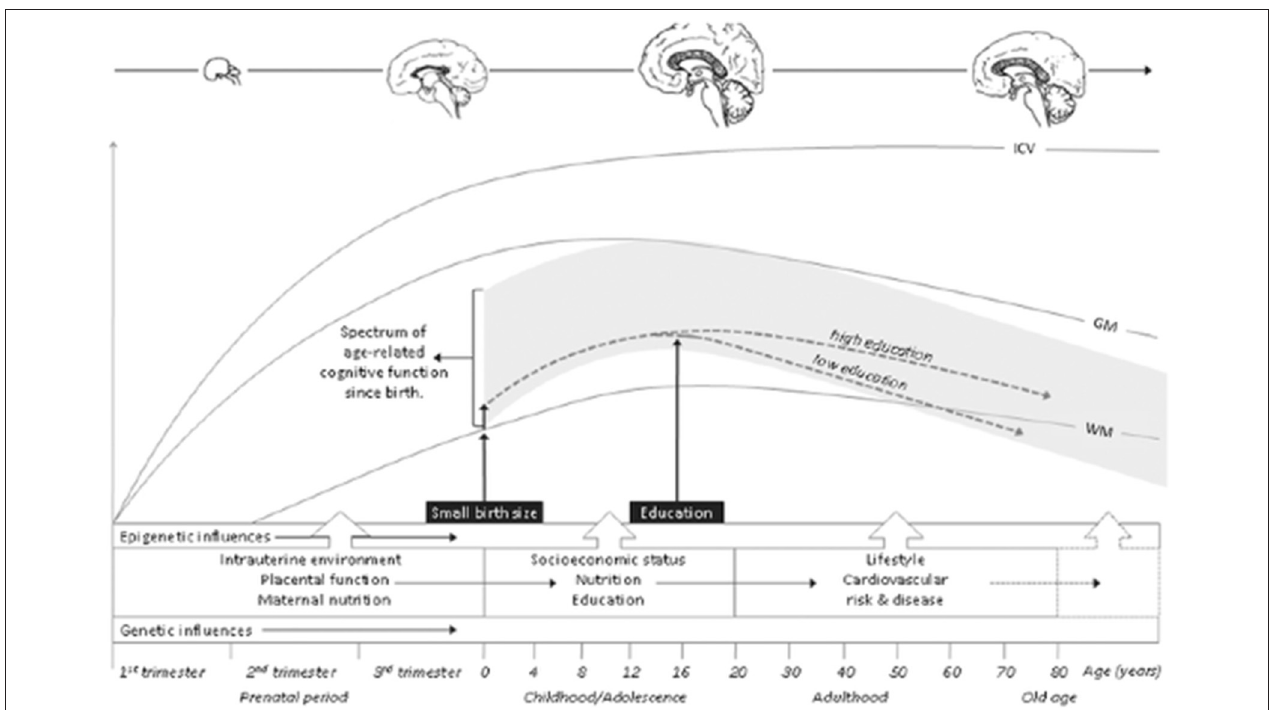
FIGURE 8 | A hypothesized model of the origins and life course of brain aging. Several “critical periods” (prenatal period, childhood/adolescence, adulthood, and old age) are identified during which an individual is at greatest risk of damage if exposed to putative risk factors. Normal development of ICV and brain volumes (GM and WM) is presented for these critical periods, and the possible different risk factors influencing brain development throughout these periods are described. Allegedly, genetics and epigenetic influences could alter brain structure and function throughout life, but their impact would probably fade with age. In addition, the spectrum of age-related cognitive ability from birth to old age is presented in this figure, with a schematic view of our findings that small birth size is related to poor cognitive functioning only in those with lower educational levels (